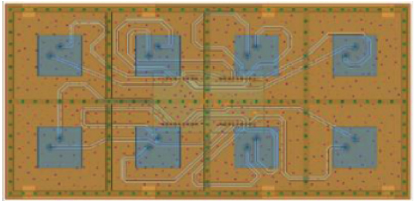
Figure 7: Antenna array for UE proposed in [61] ©2017